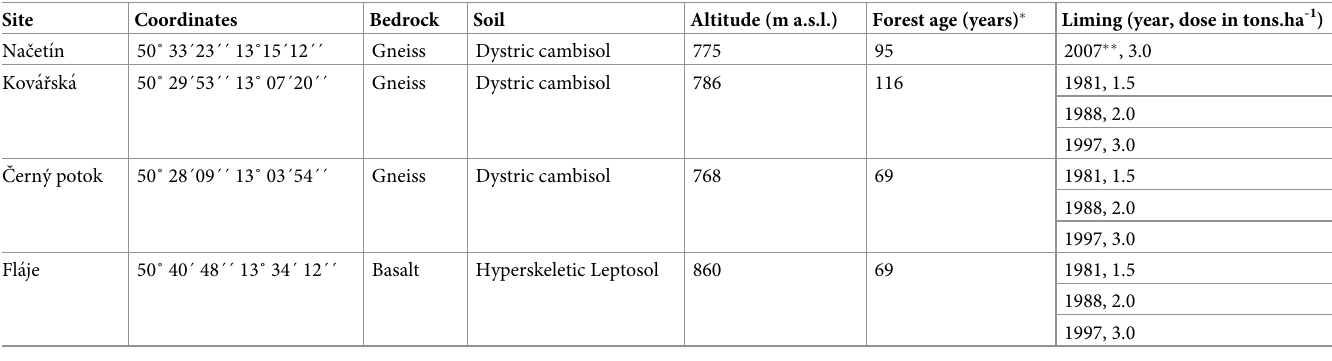
Table 1. Characteristics of studied plots in Ore Mts., Czech Republic. Site Coordinates Bedrock Soil Altitude (m a.s.l.) Forest age (years) � Liming (year, dose in tons.ha -1